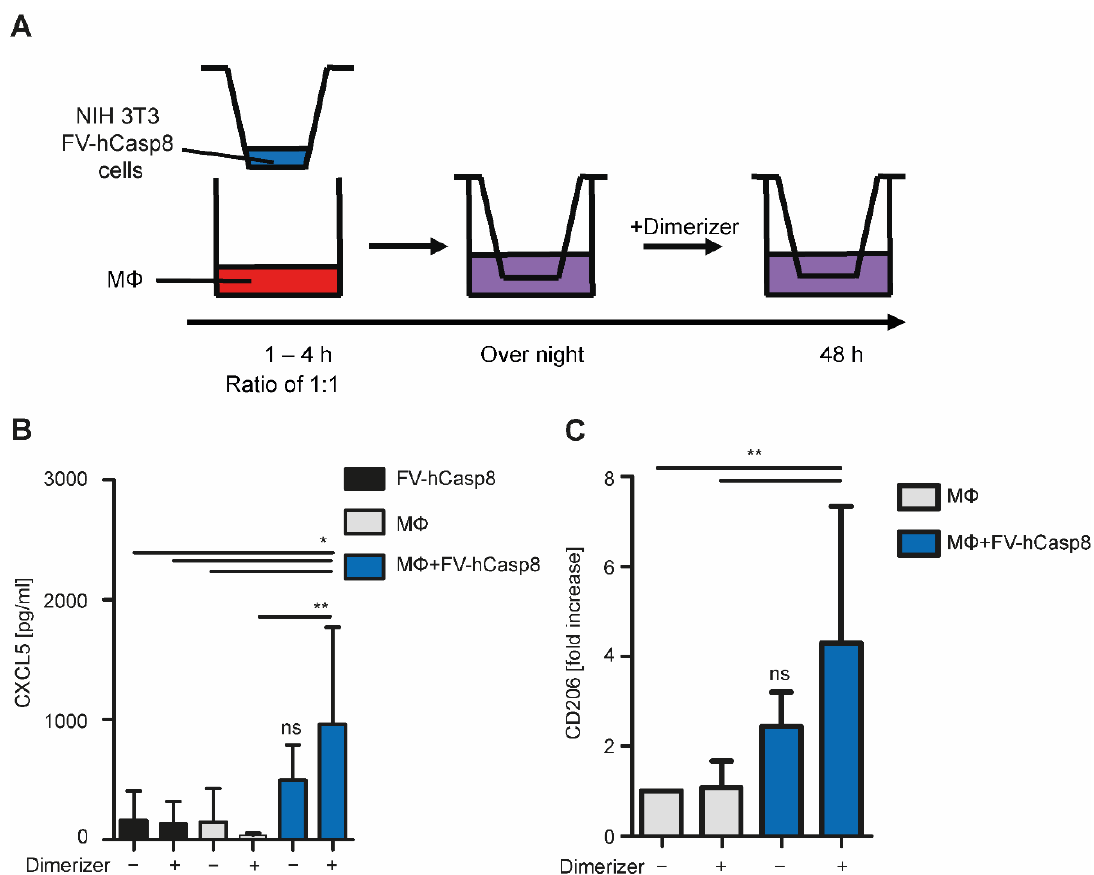
Figure 2. Establishing of a co-culture system. ( A ) Depiction of the experimental setup: Peritoneal macrophages (M Φ ) were isolated from C57 BL/6 mice and co-cultured with NIH 3T3 cells at a ratio of 1:1 in a transwell system. Cells were co-cultured over night before treatment with 10 nM dimerizer. After 48 h, cytokines and chemokines in the supernatant and RNA of the macrophages were analyzed. ( B ) Concentration of CXCL5 was measured ( n = 6); ns - not significant; * p < 0.05; ** p < 0.01. ( C) mRNA levels of CD206 were quantified. Fold increase to control (MΦ) are shown ( n = 8); ns - not significant;